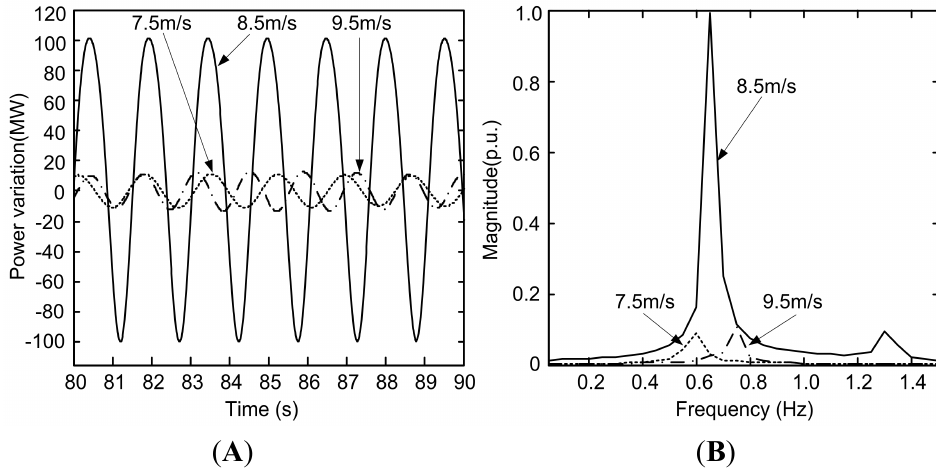
Figure 7. Tie-line power oscillations and spectrum analysis with three wind speeds: ( A ) Variation of the tie-line active power; ( B ) Spectrum